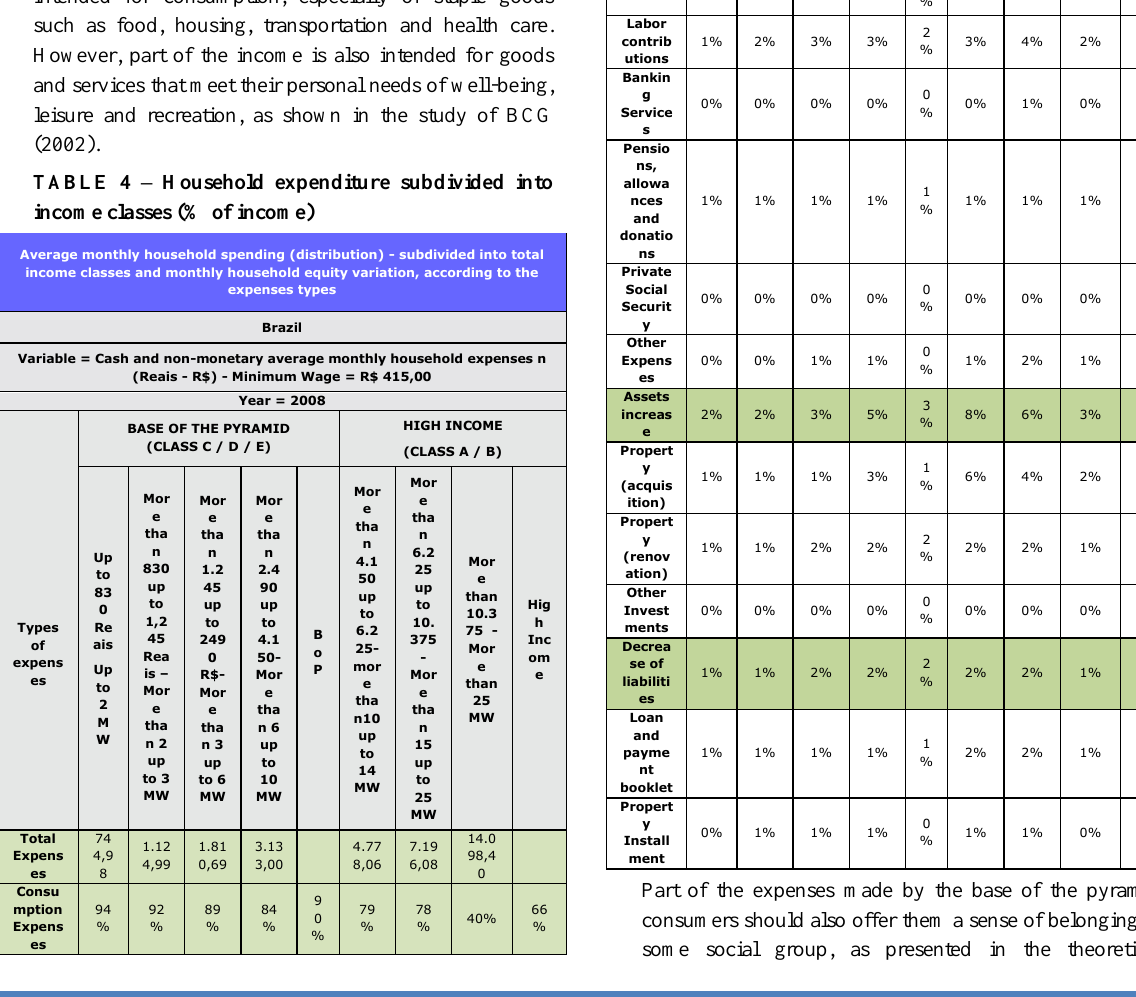
Consumption Characteristics Mapping of the Base of the Pyramid (BOP) Population in